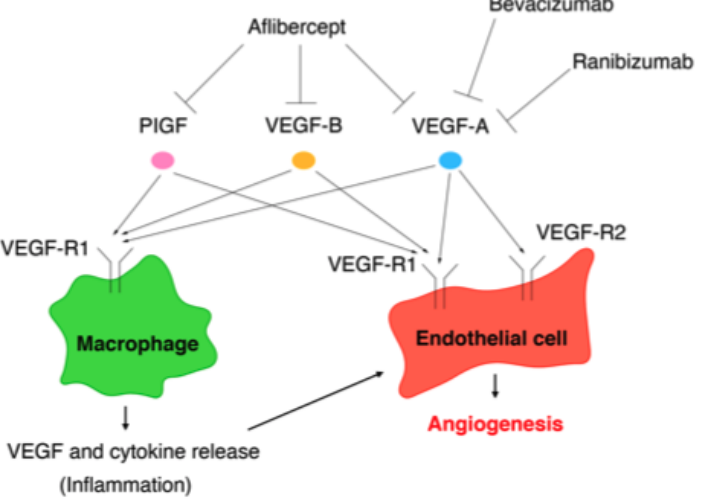
Figure 2. Vascular endothelial growth factor/vascular endothelial growth factor (VEGF) receptor pathways involved in angiogenesis and the targets of VEGF (anti-VEGF agents): bevacizumab, ranibizumab, and aflibercept.